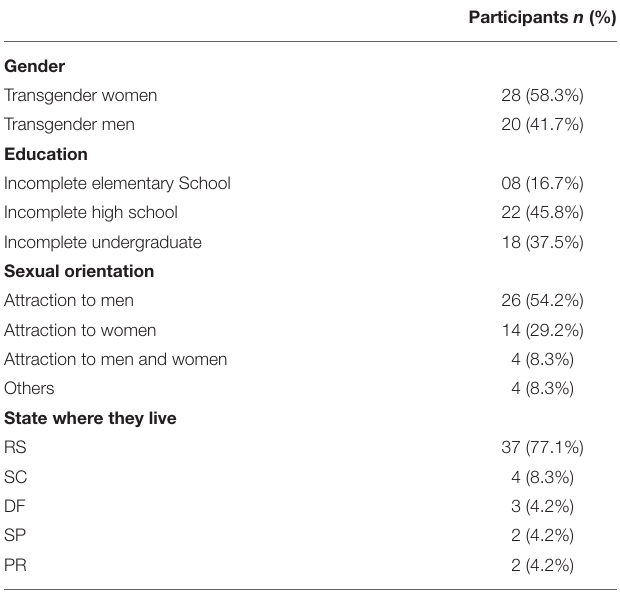
TABLE 1 | Sociodemographic profile at baseline. TABLE 2 | Absolute and relative distribution for work and monthly income in the segments before (P0), initial (P1), and final (P2).